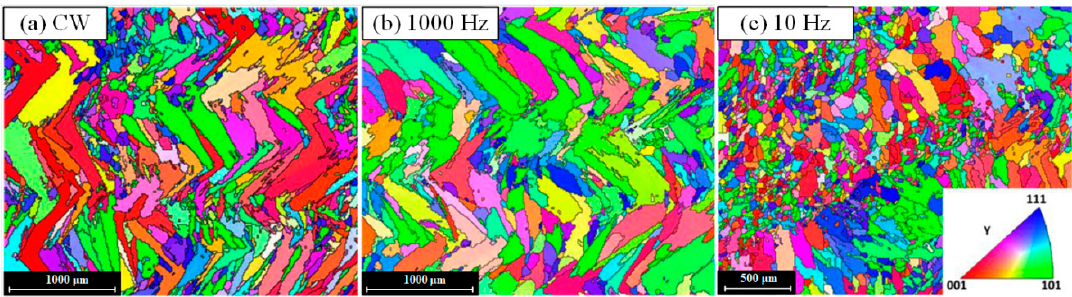
Figure 7. EBSD map of the longitudinal section zx plane during using of ( a ) CW, ( b ) PW with the frequency of 1000 Hz and ( c ) PW with the frequency of 10 Hz (Reprinted from ref. [32], copyright (2020), with permission from Elsevier).